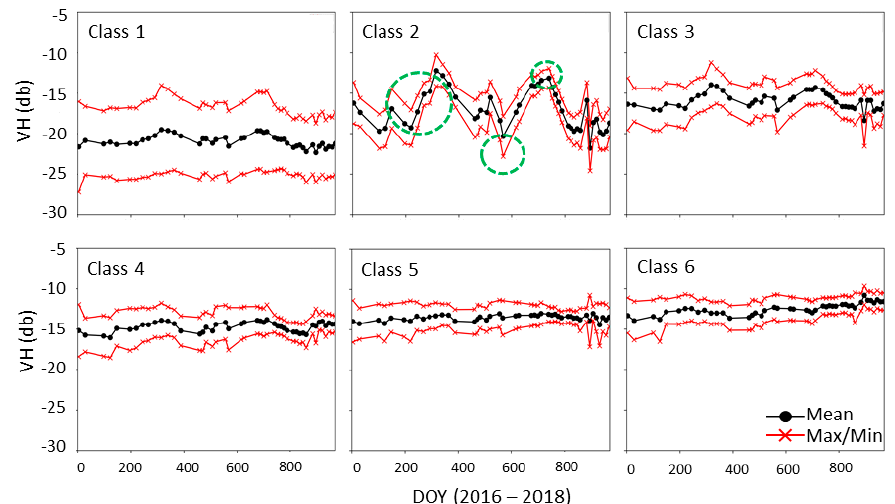
Figure 4. General land use—land cover classes were created using simple K-means clustering of time series Sentinel-1 VH to help mask out non-cropland areas and focus further time series analysis on arable landscape pixels.